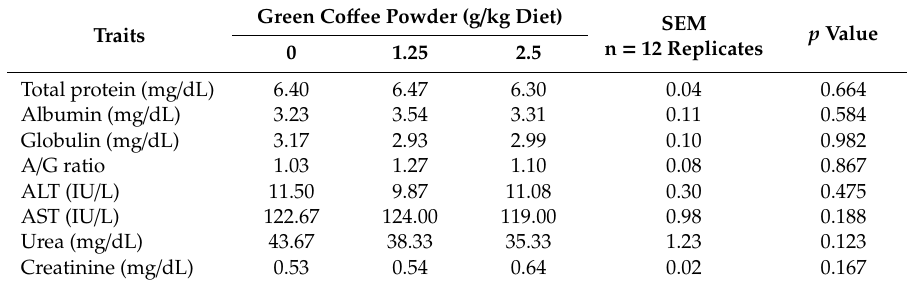
Table 4. The e ff ect of green co ff ee supplementation of serum biochemical parameters of broiler chicks at two levels (1.25 and 2.5 g GCP / Kg diet) compared to